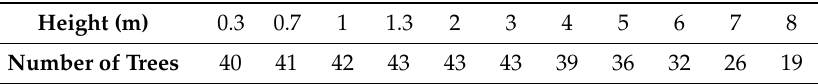
Table 2. Number of trees identified from CRP point cloud cross sections.